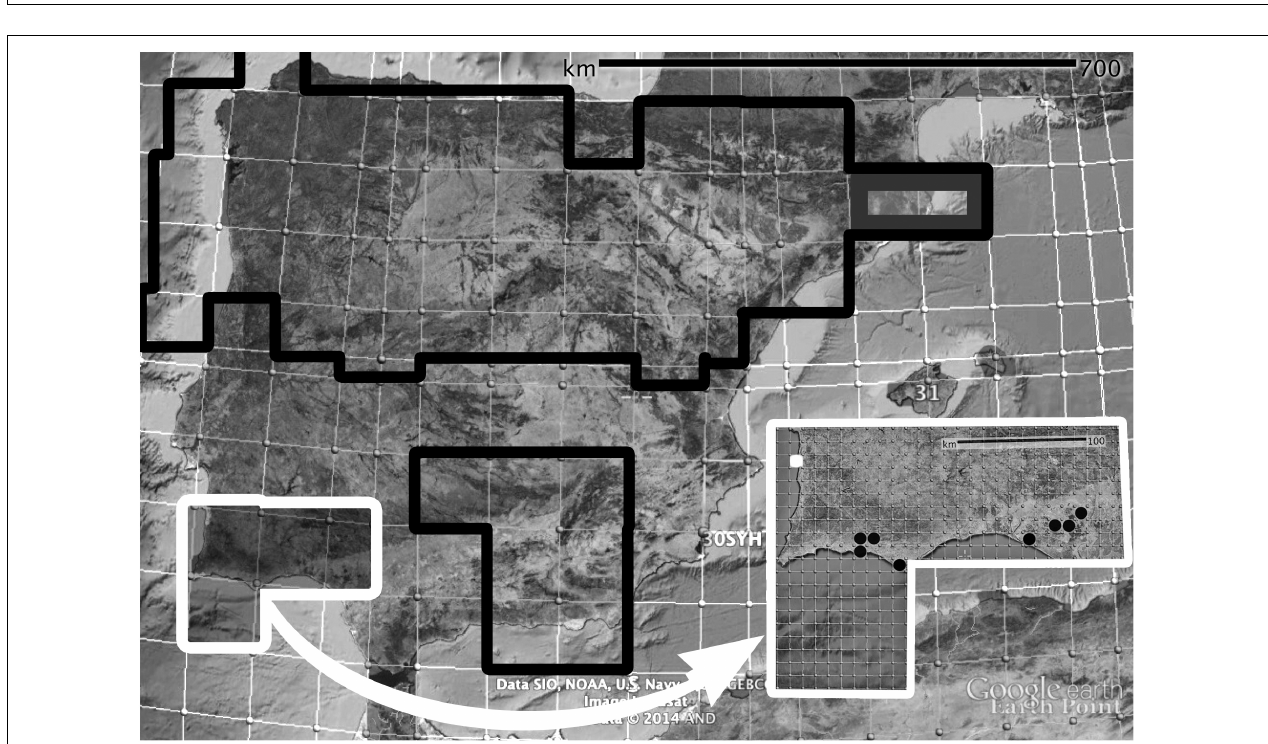
FIGURE 6 | Relative locations of four Plantago species ( P. subulata aggregate) in the Iberian Peninsula. MGRS grid (100 km): P. almogravensis and P. algarbiensis ( white ), P. holosteum ( black ), and P. subulata (gray). Detail (10 km grid): P. almogravensis ( white dot ) and P. algarbiensis ( black dots ). Images:© Google Earth 2015; gridlines:© www.earthpoint.us. Adapted from Serrano (2015), p.